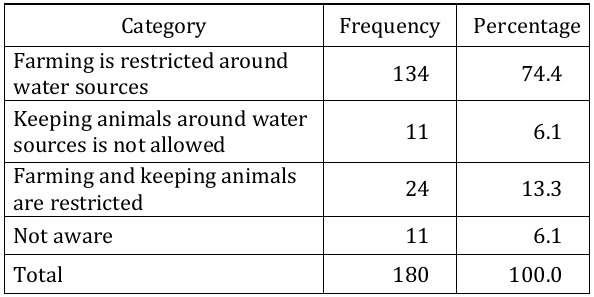
Table 2. Knowledge and awareness of respondents on the